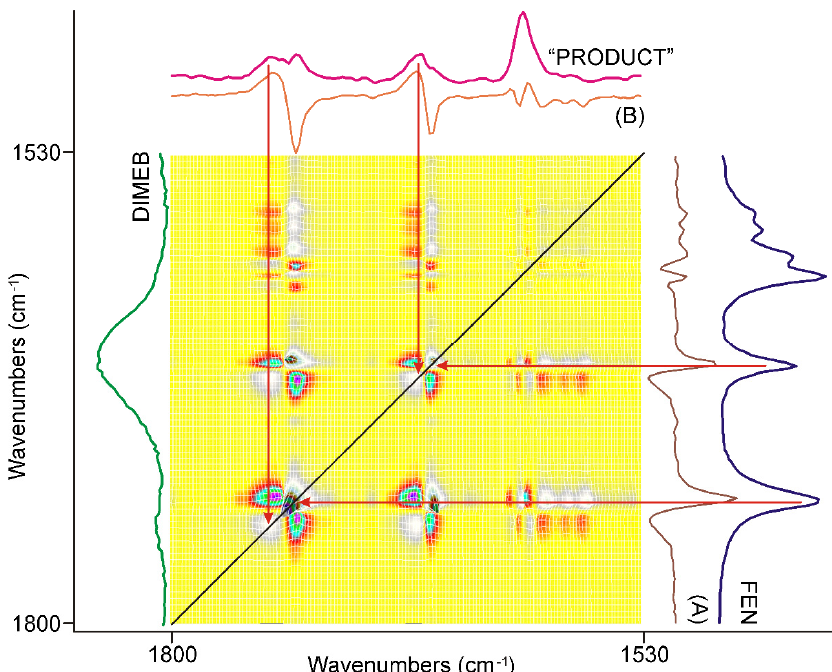
Figure 9. The synchronous correlation surface calculated from the spectra recorded during the last 20 min long period of time, between 1800 and 1530 cm − 1 , showed a very similar picture to that of the previous 20 min. The axial sections were taken at 1742 cm − 1 (A) and 1728 cm − 1 (B), confirming that the consumption of the residue of FEN was the dominating process accompanied by lesser contribution from the formation of “PRODUCT”. The range of the aromatic ring stretching modes around 1600 cm − 1 showed very low intensities.